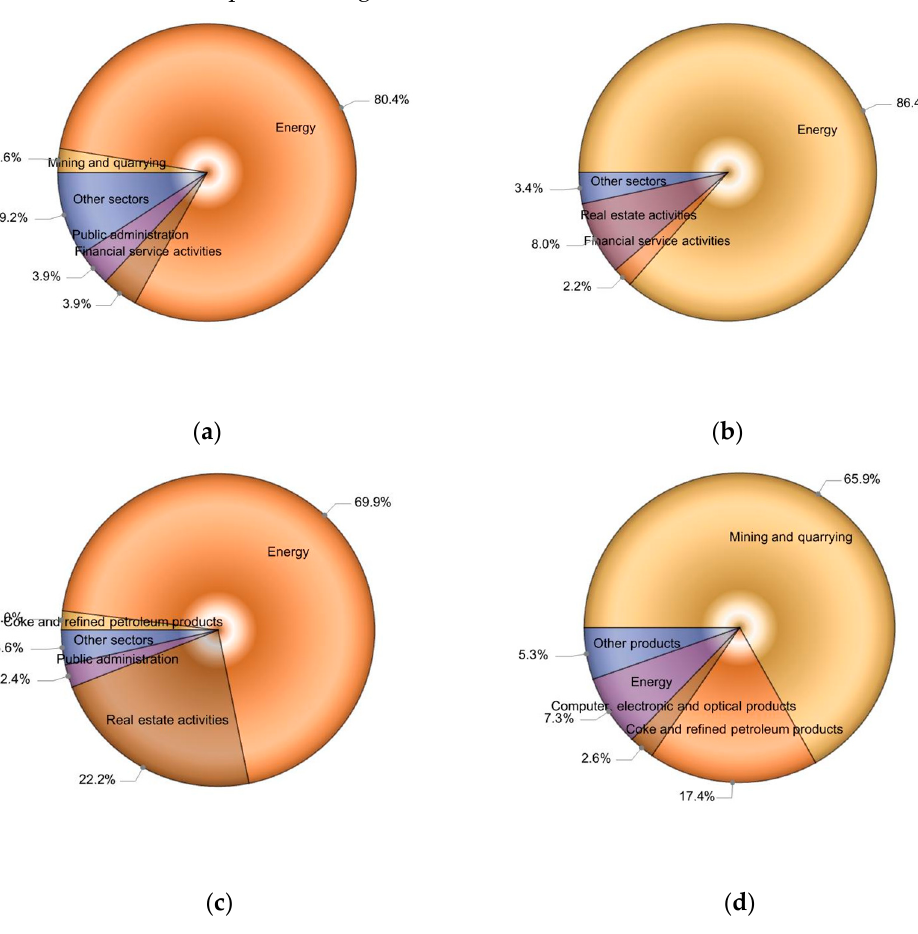
Figure 2. The Contribution of Costs to Energy Prices per Primary Input Cost and Industry of Origin: ( a ) Wages; ( b ) Profits; ( c ) Consumption of fixed capital; ( d ) Extra EU imports.